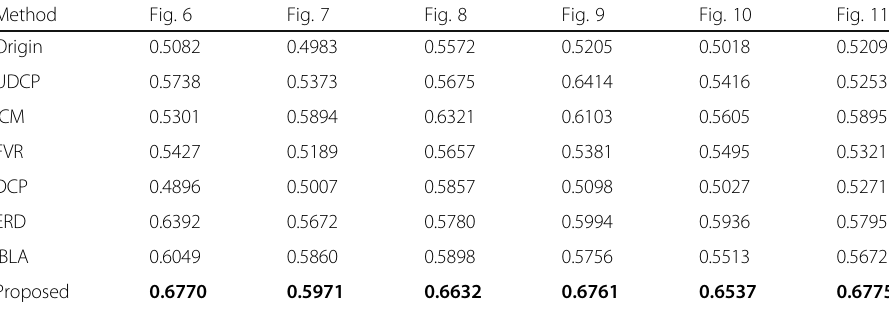
Table 1 Quantitative performance analyses based on UCIQE